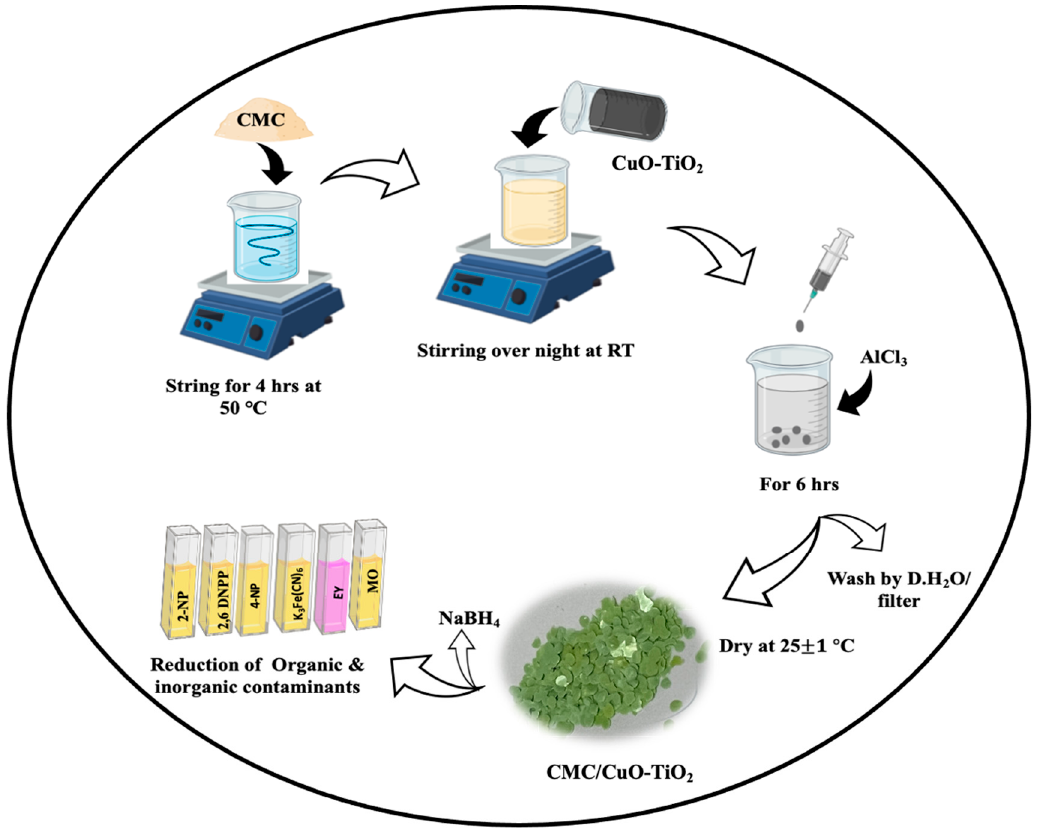
Figure 1. Schematic representation for the preparation of CMC/CuO-TiO 2 nanocatalyst beads.